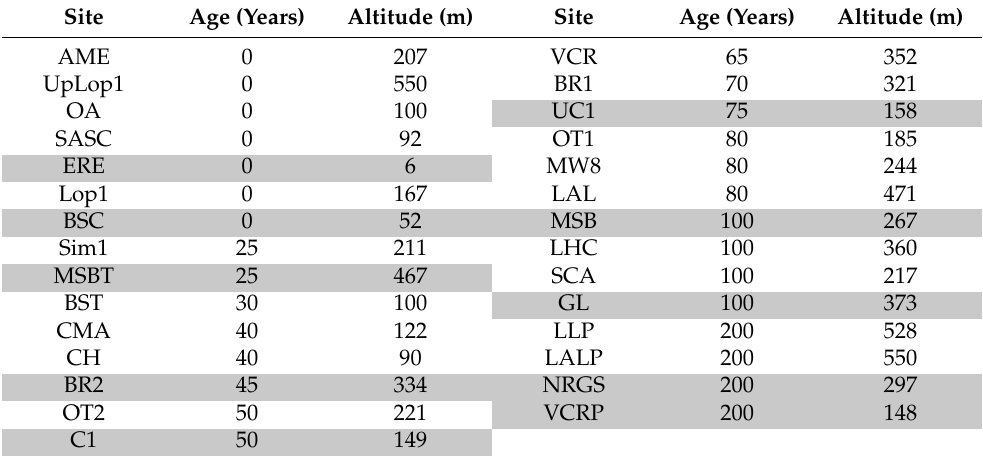
Table 1. Table of sites surveyed. Grayed out sites were not used because of cloud